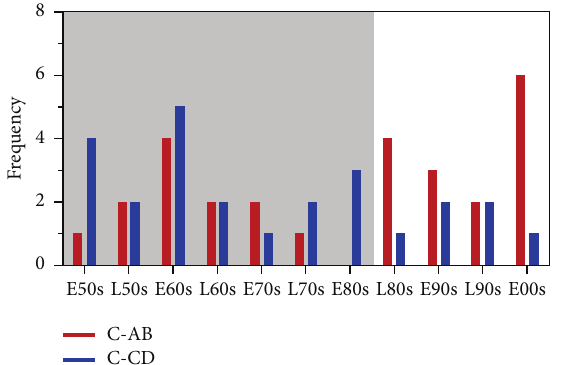
Figure 14: 5-year variation of the landfalling frequency of C-AB and C-CD of Korea-landfall TCs. The E and L characters mean “early” and “late,” respectively. For example, E50s (L50s) denotes early (late)